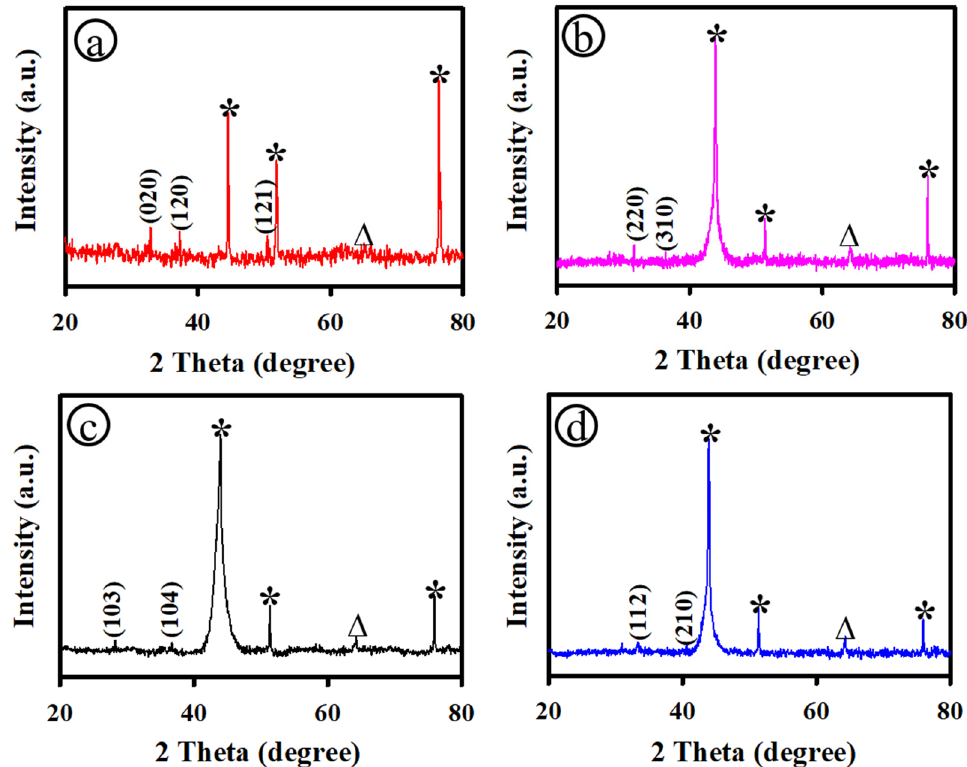
Figure 1. XRD pattern of the PS-3D-FeP@NiO|Ni ( a ), CoP@NiO|Ni ( b ), NiP@NiO|Ni ( c ), and CuP@NiO|Ni ( d ) nanostructured electrodes. The other XRD peaks were marked with a star (*) and triangle ( ∆ ) endorsed to the Ni and NiO electrode.